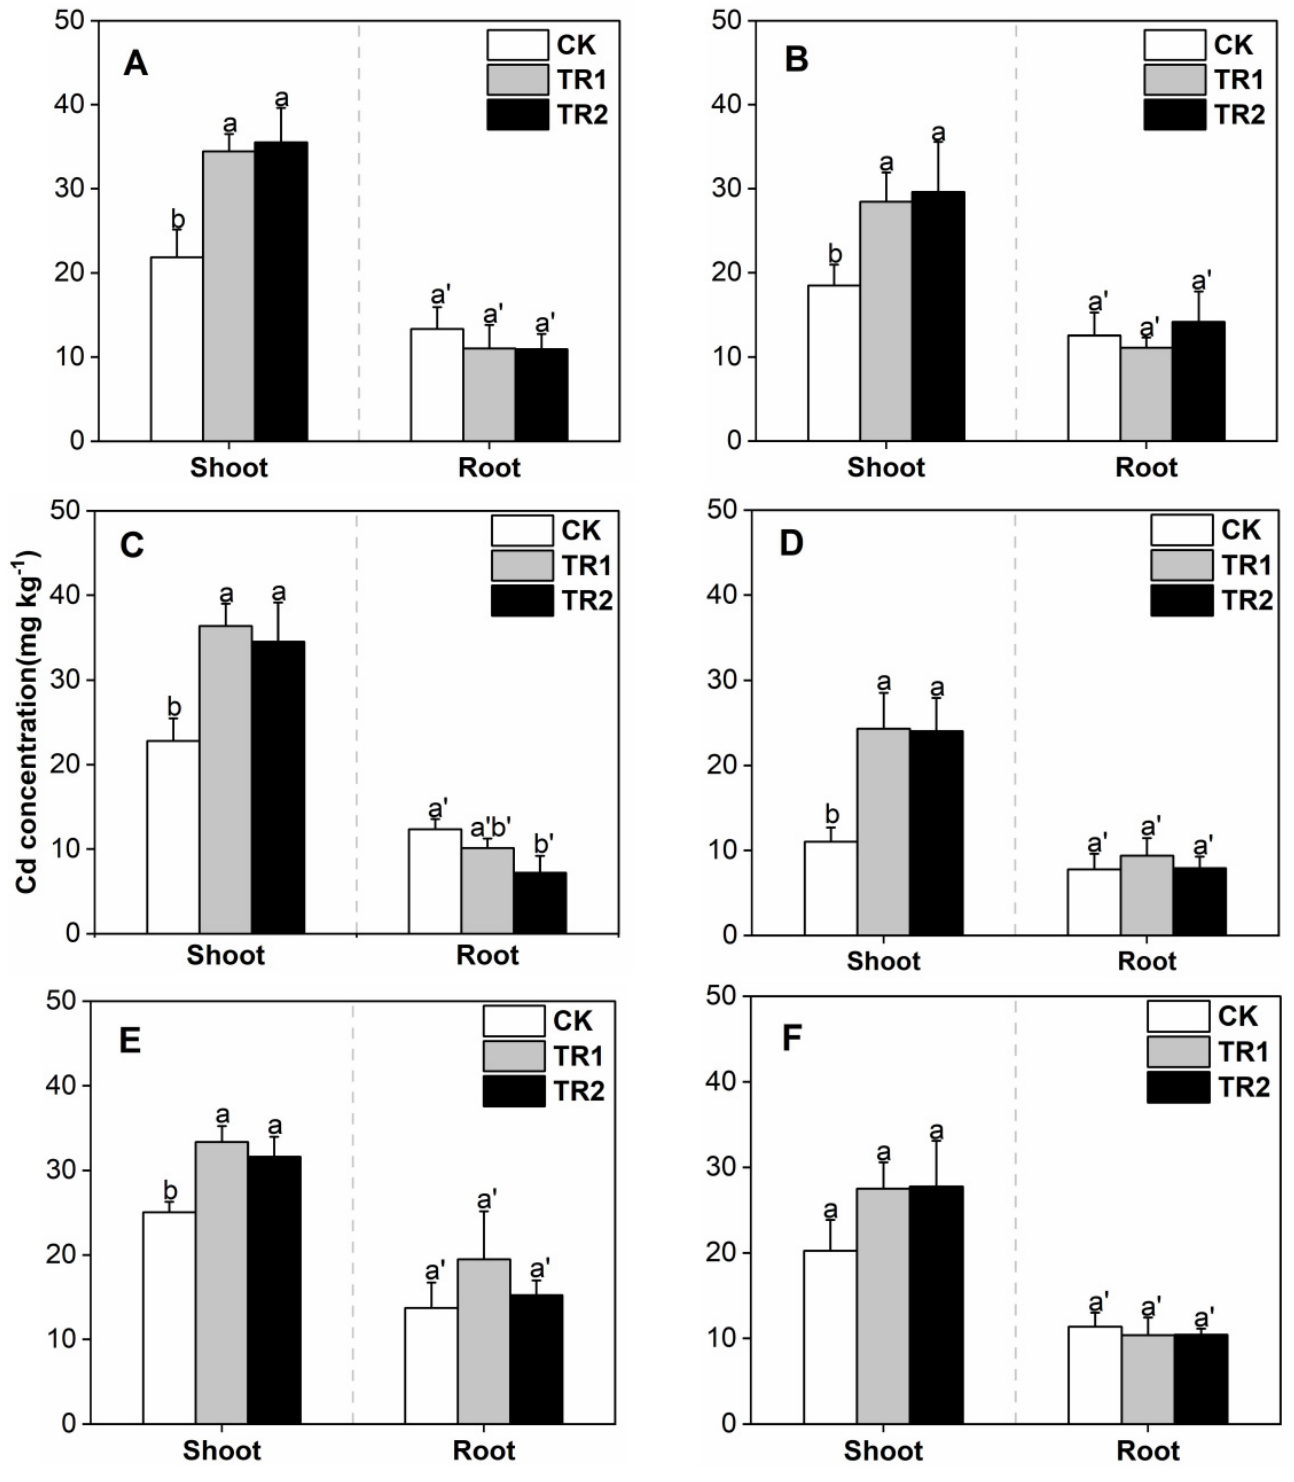
Figure 2. S. alfredii Cd concentration. ( A ) First period intercropping papaya, ( B ) Second period intercropping papaya, ( C ) First period intercropping grapefruit, ( D ) Second period intercropping grapefruit, ( E ) First period intercropping fig, ( F ) Second period intercropping fig. The different letters above the column indicate the significant differences among different treatments at p < 0.05.